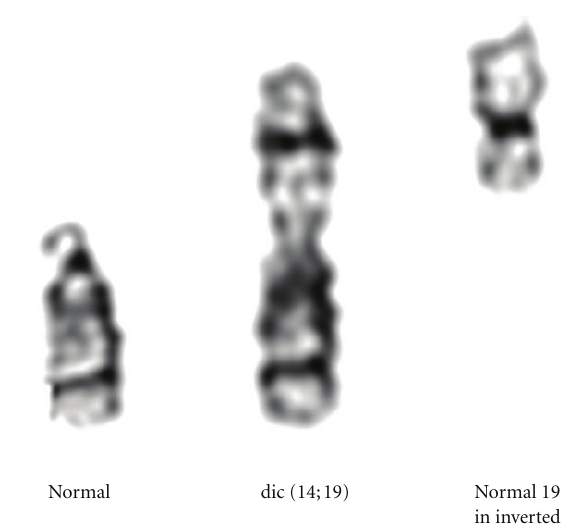
Figure 1: The partial karyogram showing the normal chromosome 14, dicentric 14 and 19, and normal chromosome